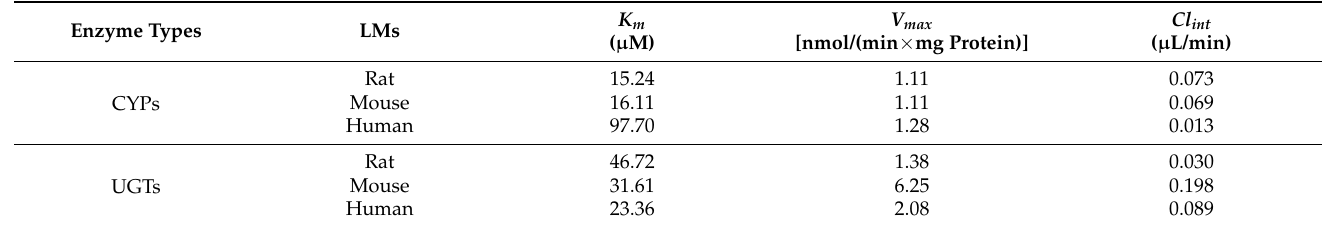
Table 3. Enzyme kinetic parameters in rat, mouse and human LMs.